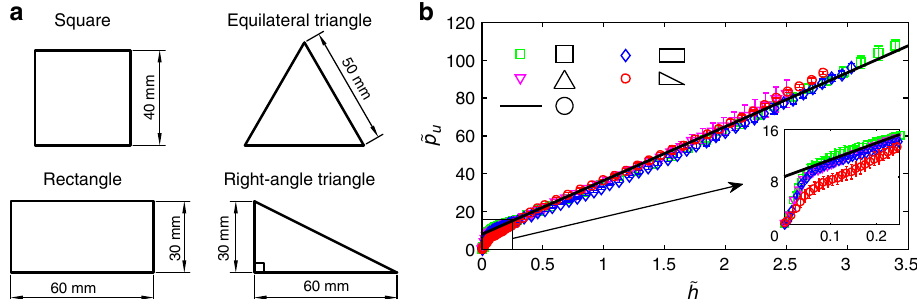
Fig. 3 Independence of the force – depth curve of the intruder ’ s cross-section shape. a The cross-sections, normal to the direction of penetration, of the polygonal prisms used in the experiments. b Dimensionless pressure – depth curves for different polygon prisms penetrating glass beads 1. The black line is the fi t in Fig. 2a; inset: a zoom in on the nonlinear regime. ~ h is measured in units of the equivalent radius, R e ¼ 3 samples for each shape and the error bars represent the standard deviation over the samples. The fi ts qualities are: R 2 >0.997, 0.992, 0.998, and 0.993, respectively, for the square, rectangle, equilateral triangle and right-angle triangle. The experimental data of all the polygon intruders collapse on the fi tted curve in Fig. 2a for all the cylinders (solid line), suggesting the K ϕ is a pure material constitutive parameter